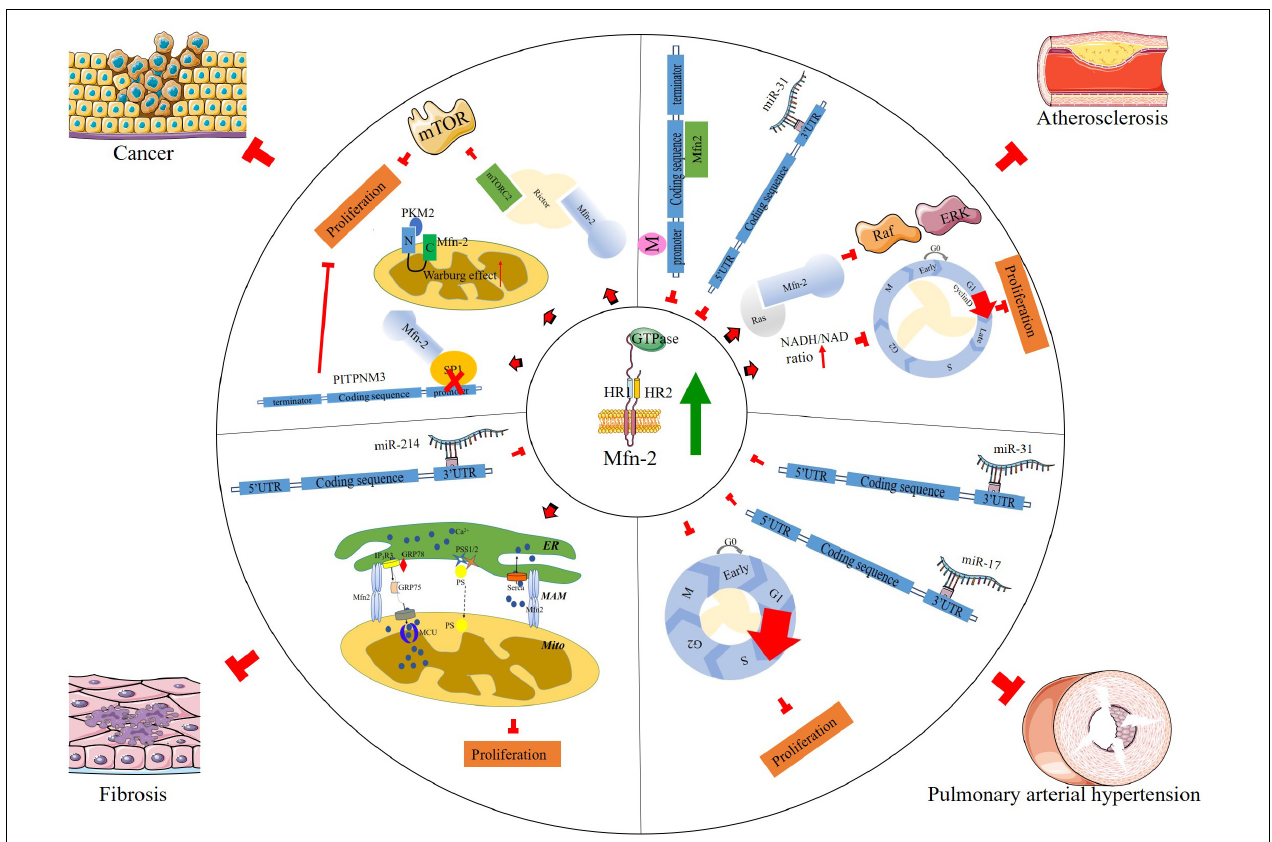
FIGURE 2 | Signaling pathways mediate cell proliferation in various